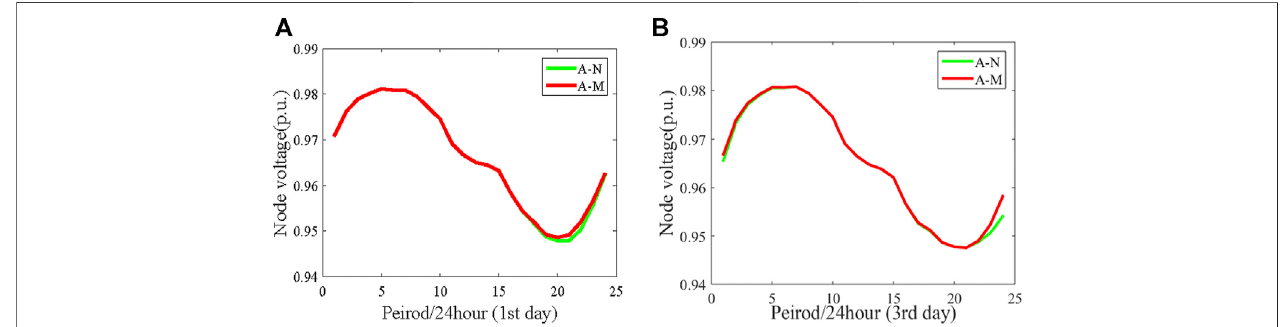
FIGURE 11 | Voltage comparison of node 15 for different attack durations. (A) First 24 h (1 st day). (B) Third 24 h (3 rd